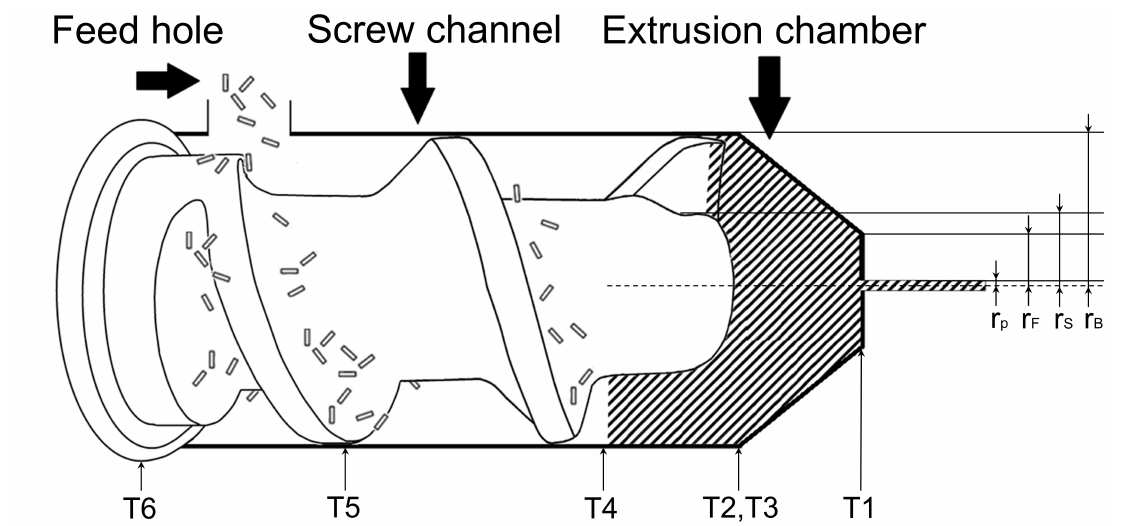
Figure 1. Principal sketch of the metal screw extrusion process showing granule feeding on the left-hand side and material consolidation into a solid plug in the hatched area. A dense profile is extruded on the right-hand side. The process is monitored by thermocouples